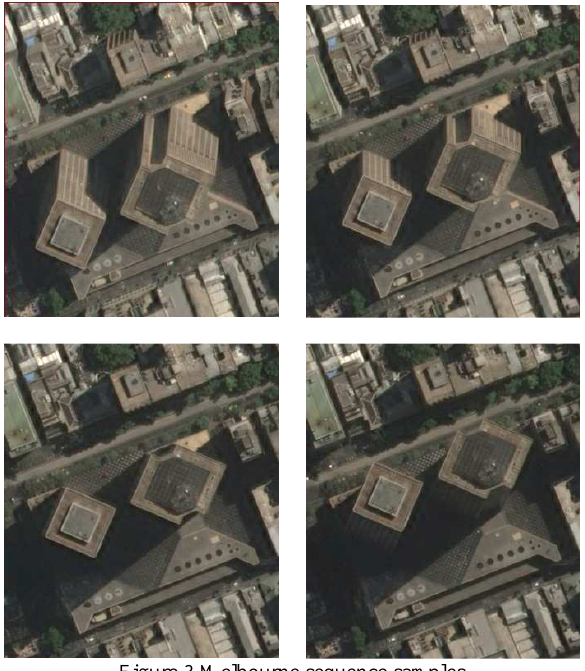
Figure 3 Melbourne sequence samples